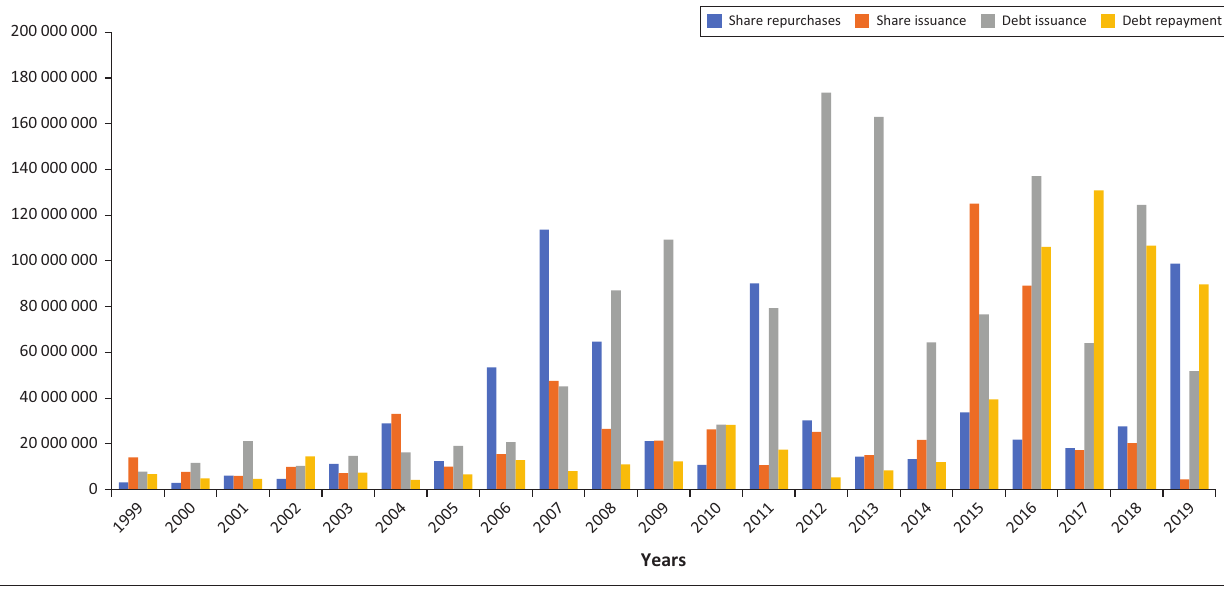
FIGURE 1: Variations in financing decisions.